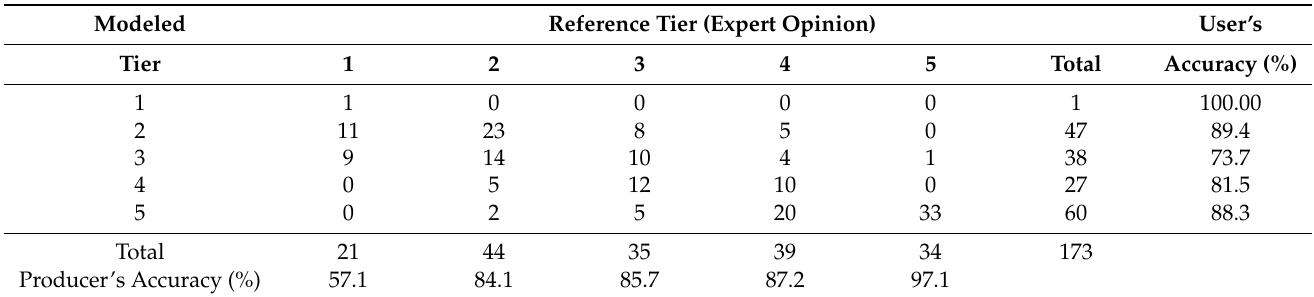
Table 3. Omission–commission matrix for validating the ecological condition class modeling effort based on the parameters used in Table 1 and allowing ± 1 modeled